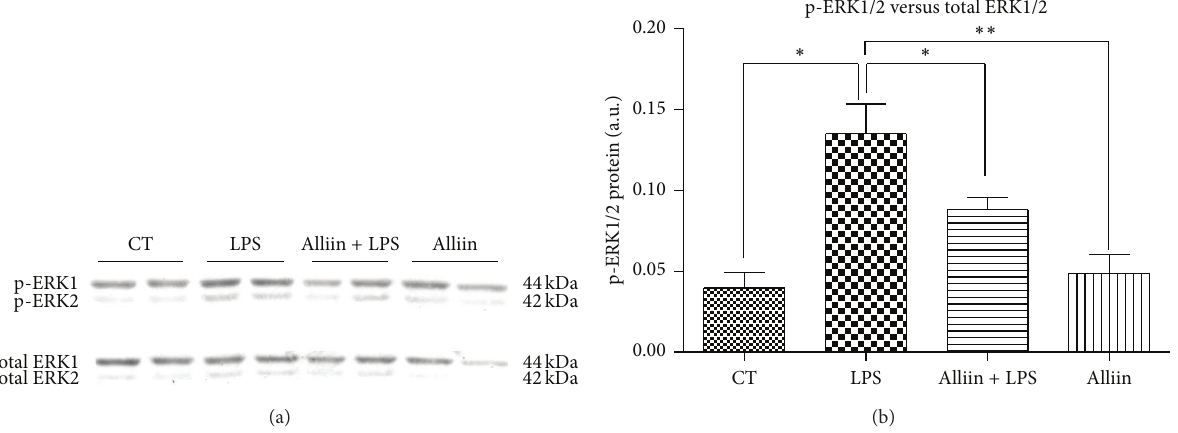
Figure 3: Levels of phosphoextracellular signal-regulated kinase (ERK1/2 p44/p42) in mouse 3T3-L1 adipocytes. Cells were pretreated for 24 h with alliin 0.1 mM and subsequently exposed to 100ng/mL of lipopolysaccharides (LPS) for 1h afterward. (a) Representative Western blot with phospho-ERK1/2 and ERK1/2 antibodies; (b) protein levels of phospho-ERK1/2 and ERK1/2 in total cell extracts. CT control; AU arbitrary units. Data are expressed as mean ± standard deviations (SD) of three independent experiments ∗ 𝑃 ≤ 0.05 ; ∗∗ 𝑃 ≤ 0.01